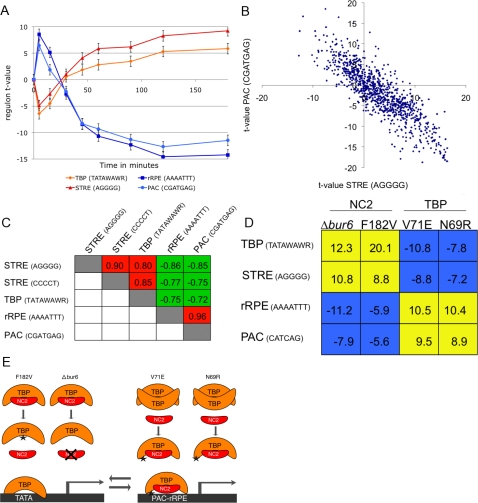
Motif-based dissection of the Environmental Stress Response.(A) Transcriptional response during DTT stress [27] of four regulons based on motifs (see text) associated with the Environmental Stress Response (ESR). (B) Scatter plot of the t-values for the 936 experiments in our database for the STRE versus the PAC regulon, showing a strong negative correlation (r = −0.85). (C) Strongly coupled antagonism between STRE/TBP and PAC/rRPE motifs. Shown are Pearson correlation coefficients for all pairwise comparisons of the t-value profiles for the four motifs. All r-values correspond to an E-value<10−14. (D) Evidence for interaction between PAC/rRPE and the factor NC2. Shown is the response of the four motif-based regulons to deletion of one of the components of NC2 (bur6Δ), as well as mutations to TBP that affect its dimerization (V71E and N69R) or its interaction with NC2 (F182V). (E) Hypothetical binding of TBP/NC2 to the TATA and PAC-rRPE (core) promoter. The left panel illustrates the inability of the TBP mutant F182V and the NC2 mutant Δbur6 to form a TBP/NC2 complex, as a consequence of which more TBP is available to bind and initiate transcription at TATA-containing promoters. The right panel illustrates the inability of the TBP mutants V71E and N69R to form the inactive homodimeric TBP complex, causing more TBP/NC2 complexes to be formed, which (directly or indirectly) stimulates transcription from PAC/rRPE promoters.